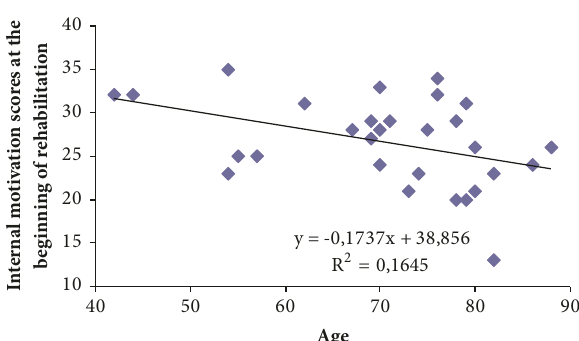
Figure 1: Correlation between age and internal motivation at the beginning of